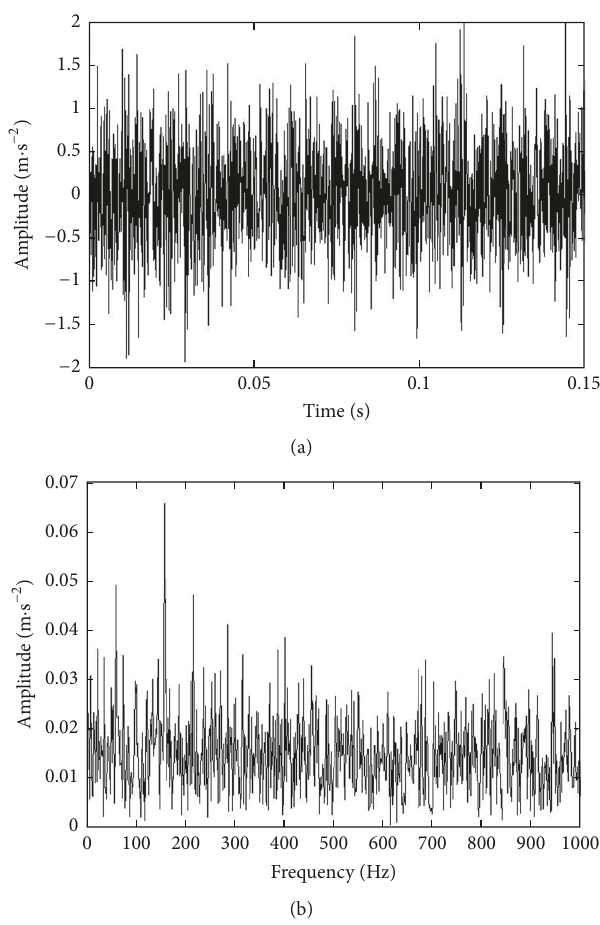
Figure 2: Fault signal with strong noise: (a) waveform in the time domain; (b) frequency